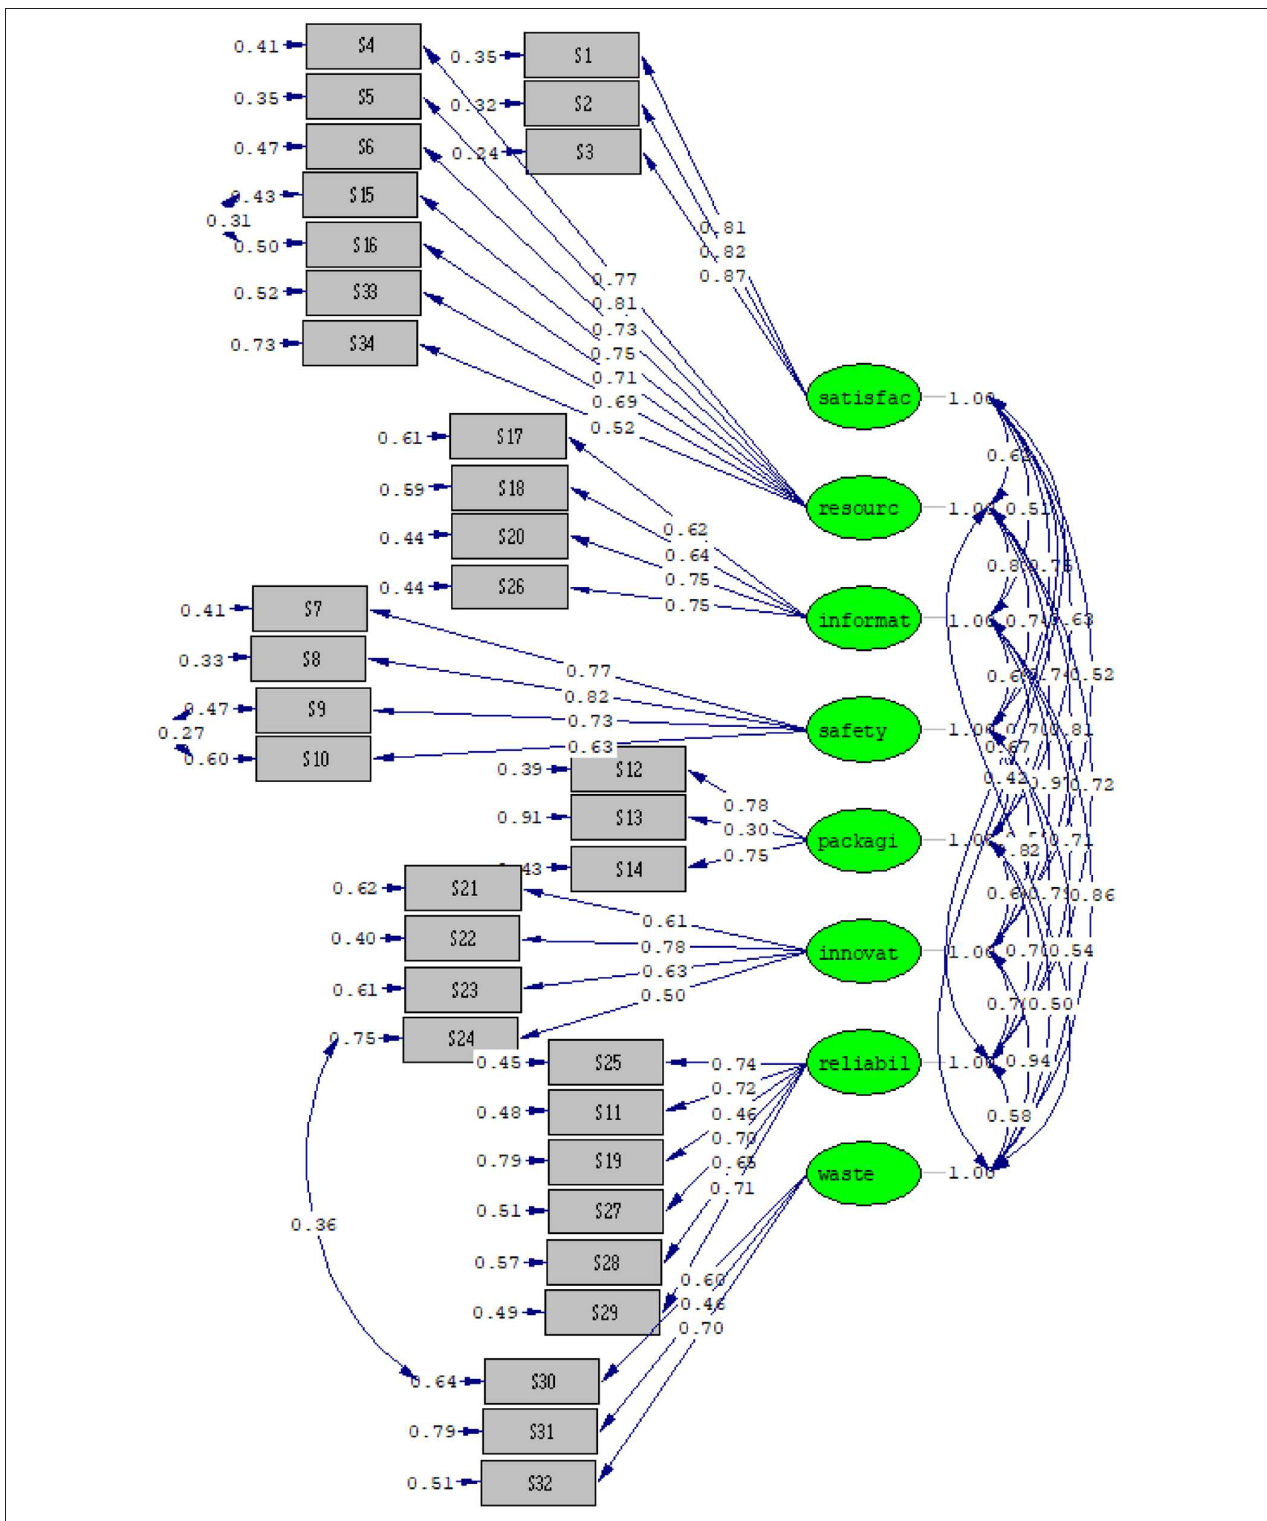
FIGURE 5 | Measurement model (CFA) explaining the relationship between measurement variables and latent variables.